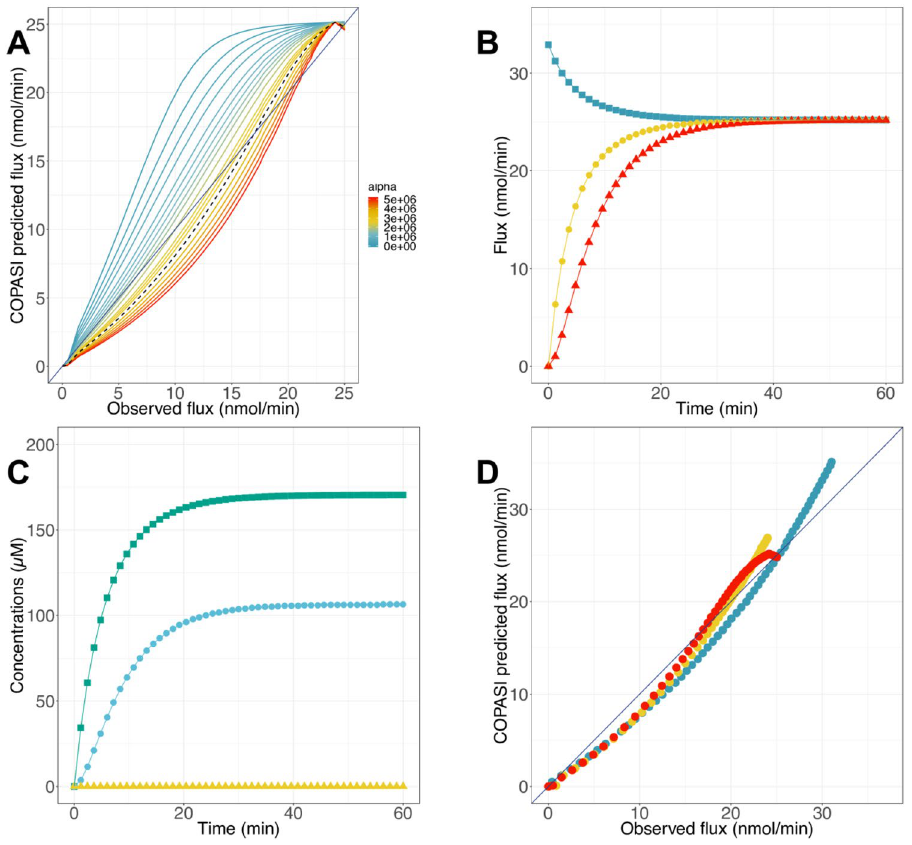
Figure 6. Flux and metabolite concentration predictions with COPASI model with an added adjustment term. ( A ) Flux predictions by the model when PPDK activity is varied. Dotted line: curve obtained with the best adjustment term (3,088,970). (B ) PGAM (blue squares), ENO (yellow circles) and PPDK (red triangles) fluxes predicted as function of time. ( C ) 2PG (green), PEP (blue) and Pyr (yellow) concentration predictions. ( D ) Flux predicted by the model. RMSE = 1.71 nmol·min −1 , MAE = 1.47 nmol·min −1 , R 2 = 0.98. Circle colors refer to the varied enzyme activity: PGAM (blue), ENO (yellow) or PPDK